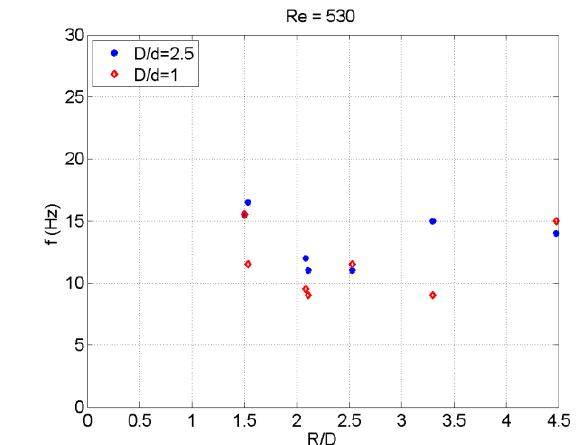
Figure 3. Relationship between the frequency and the pitch distance for Re 530